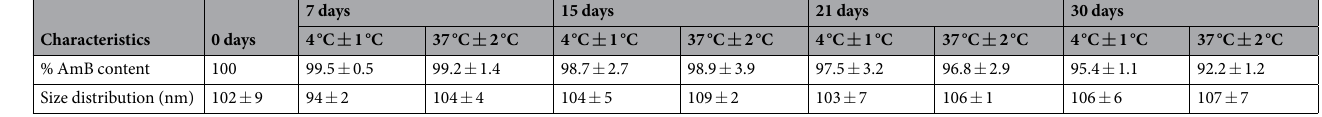
Table 5. Stability studies of freeze-dried AmB-nanoassembly stored as powder.